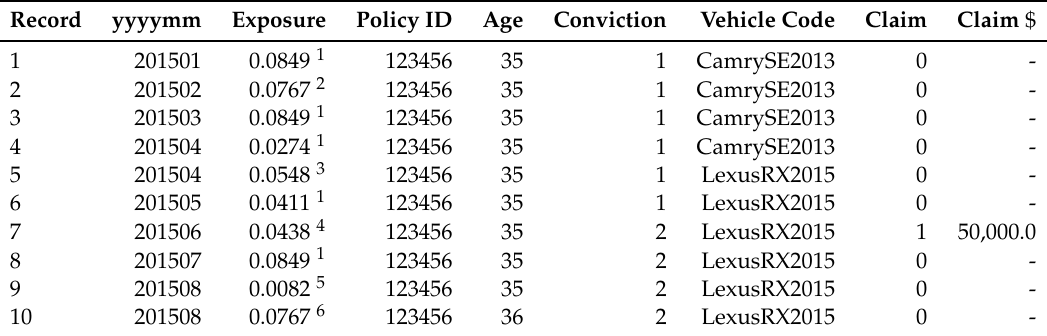
Table 2. A simple illustration of the bookeeping in actuarial